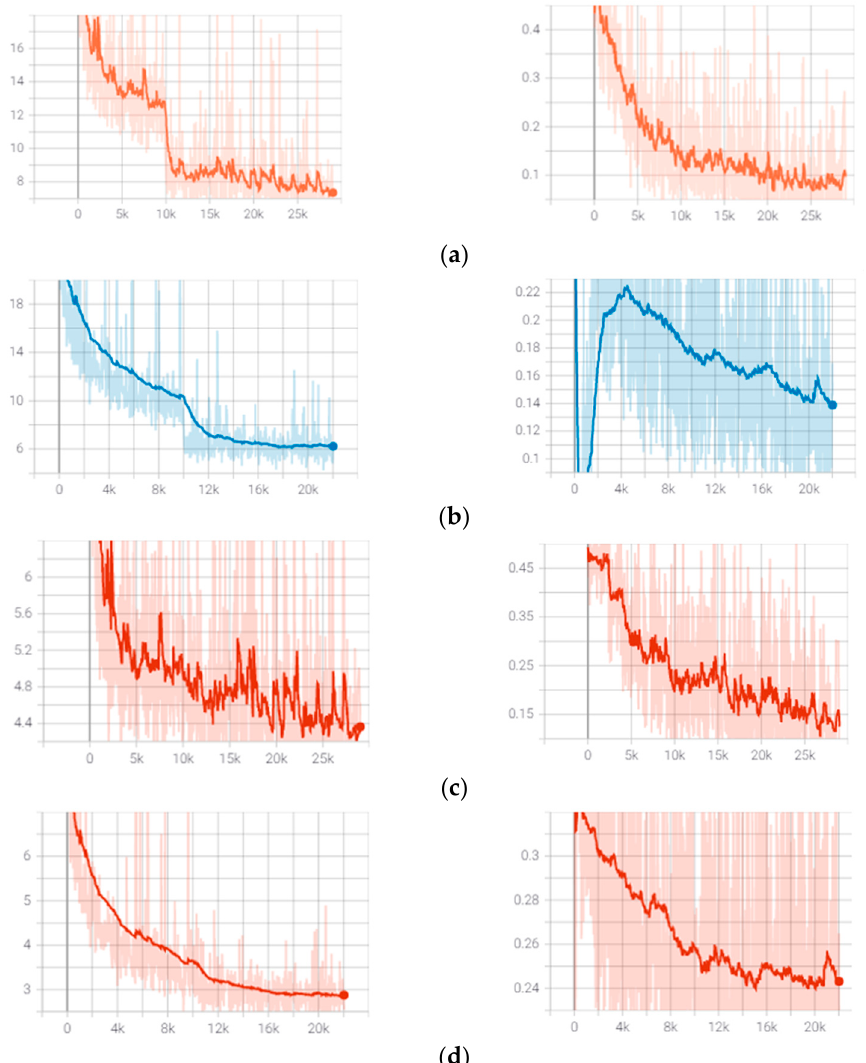
Figure 2. The convergence of the generator ( left ) and discriminator ( right ) losses of ( a ) CycleGAN-VC, ( b ) CycleGAN-VC2, ( c ) CycleGAN-IC, and ( d ) CycleGAN-IC2.